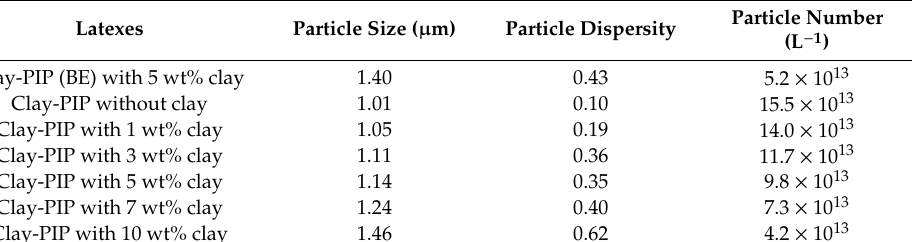
Figure 2. The effect of different emulsion polymerization methods batch (BE) and starve-fed (SFE) techniques, on the particle size of the polyisoprene latexes modified with 5 wt% nanoclay relative to the monomer content. Table 4. Polymer particle size and polymer particle number of Clay-PIP latexes with varied nanoclay contents prepared using batch (BE) and starve-fed (SFE) emulsion polymerization techniques.